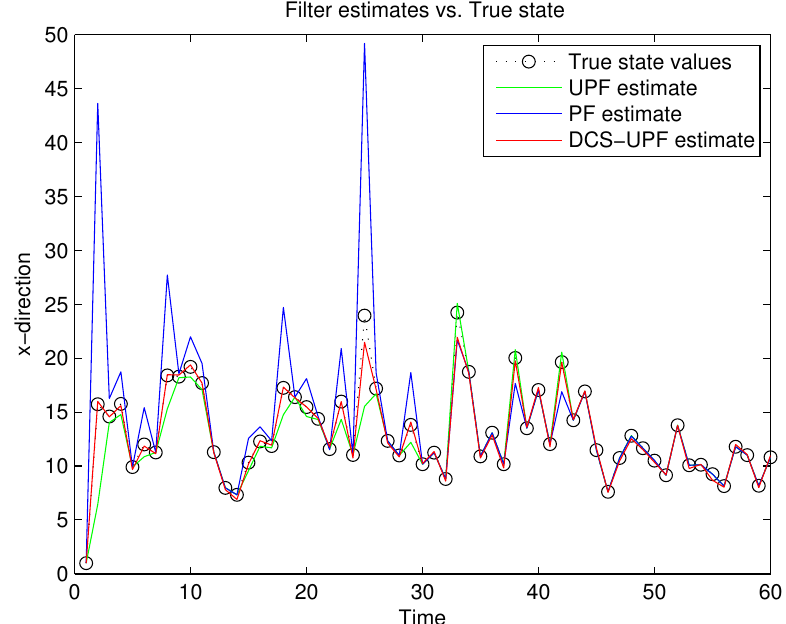
Figure 3. Target trajectory in X-direction.